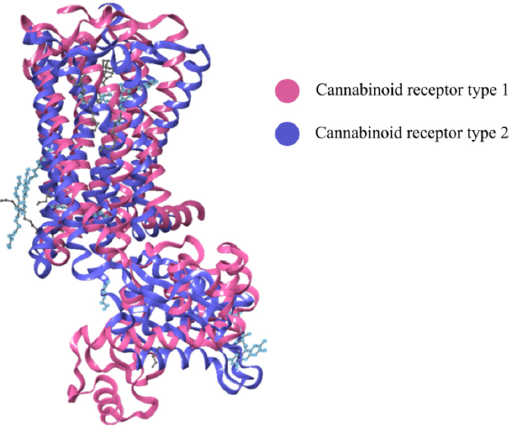
Figure 4. Superposition of AM6538@CB1-R (5TGZ from PDB) (pink) and AM10257@CB2-R